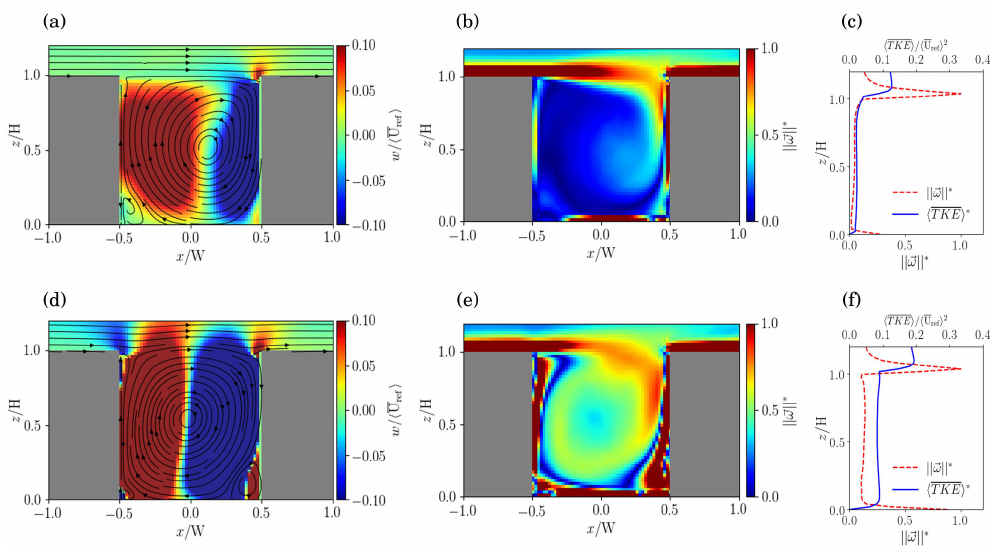
Figure 16. Flow structures for stratified flow within an AR = 1 street canyon: ( top ) stable conditions (Rb = 0.38); ( bottom ) unstable conditions (Rb = 0.39). ( a , d ) Spatially averaged streamlines; − ( b , e ) spatially averaged vorticity magnitude; ( c , f ) vertical profiles of normalised TKE and vorticity magnitude. See Figure 4 for additional figure details.